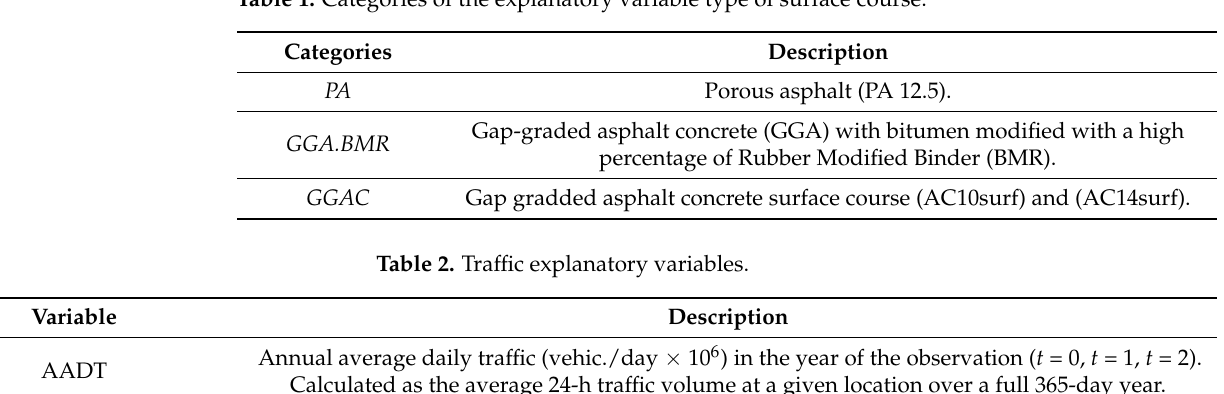
Table 1. Categories of the explanatory variable type of surface course.